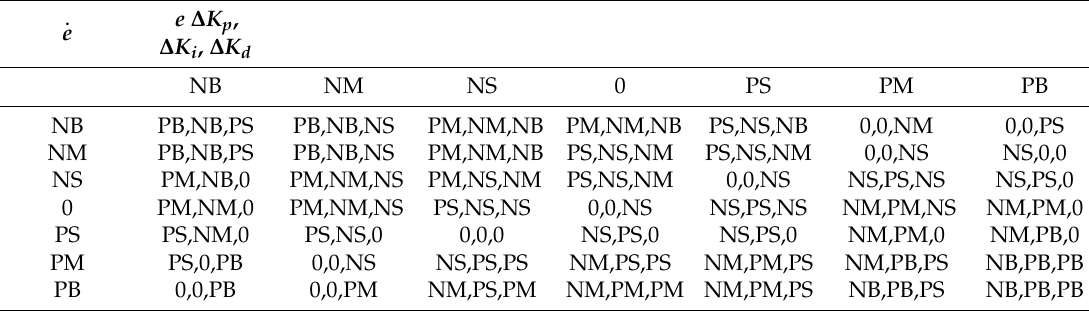
Table 1. Fuzzy inference rules of ∆ K p , ∆ K i and ∆ K d